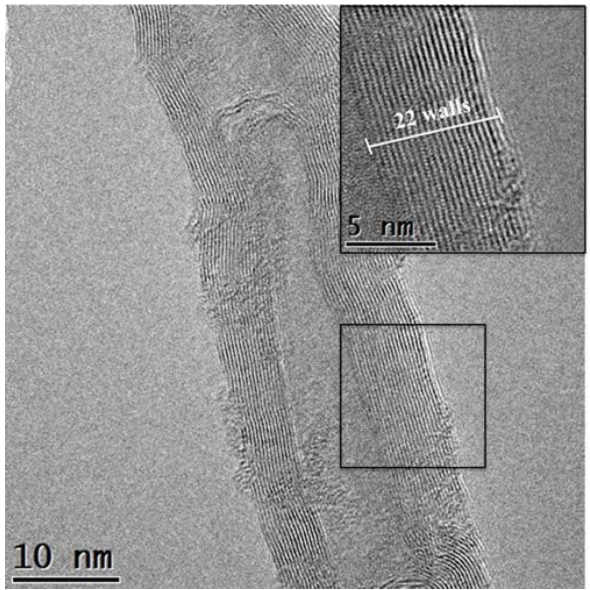
Figure 1: HRTEM image of MWCNT showing 22 number of walls